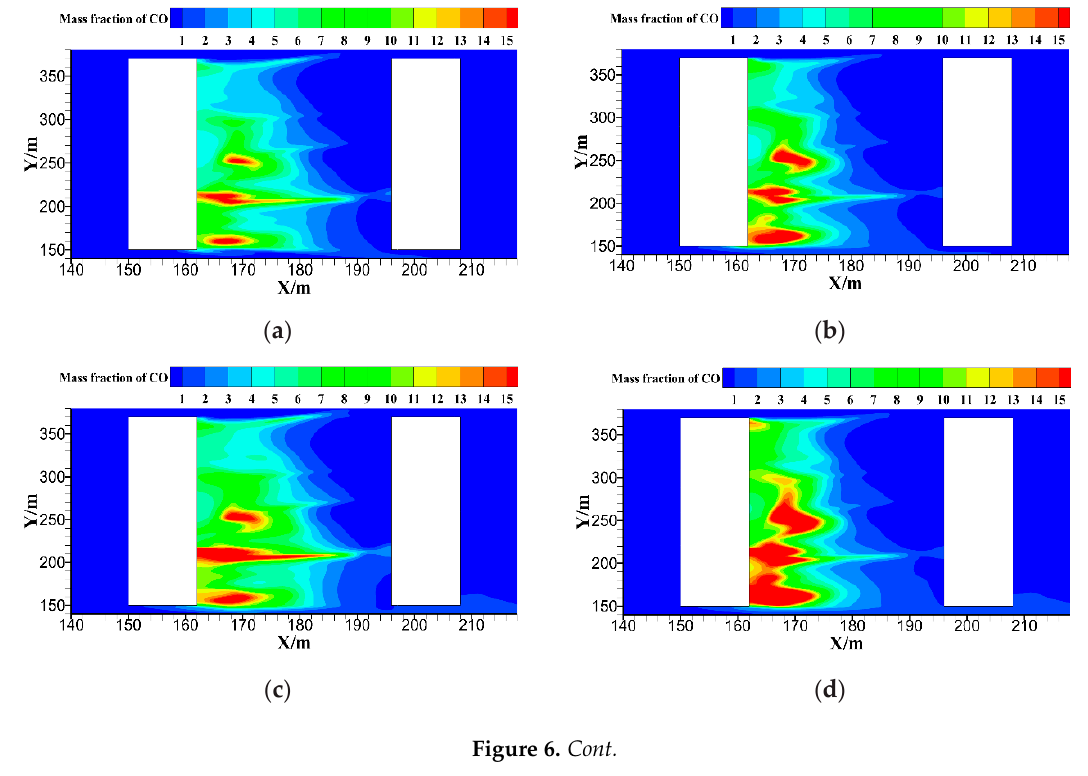
Figure 5. Vertical distributions of streamwise velocity ( a ) and normalized mean concentration ( b ) at x/H =